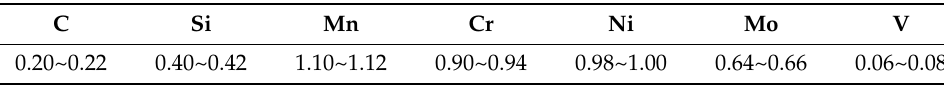
Figure 1. Schematic diagram of the production process of the test steel.